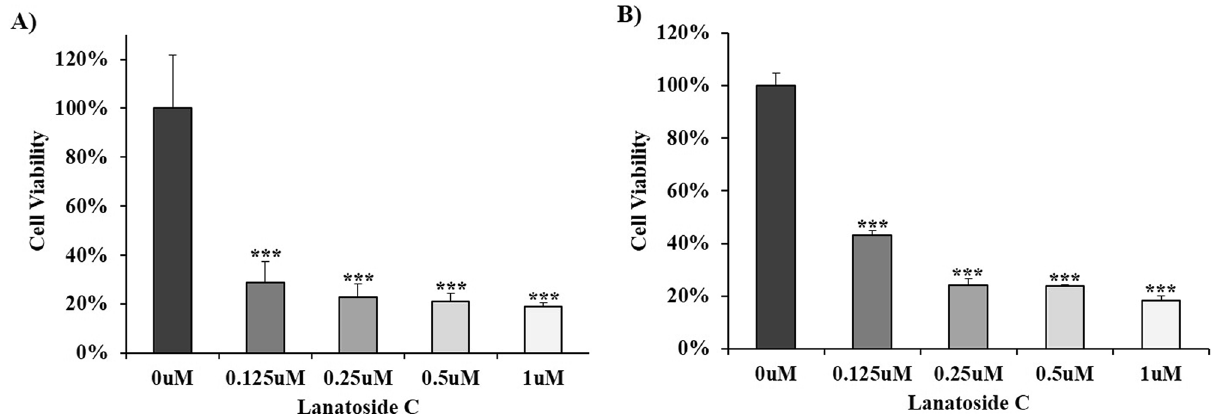
Figure 1. Lanatoside C suppressed growth of cancel cell lines. Inhibitory effect of lanatoside C on cell viability of NCI-N87 ( A ) and MDA-MB231 ( B ) cells. Data are presented as percentage of cell viability in which the 0.01% DMSO treated control sample is set 100%. The average of experimental triplicates ± standard deviation is shown. *** p <